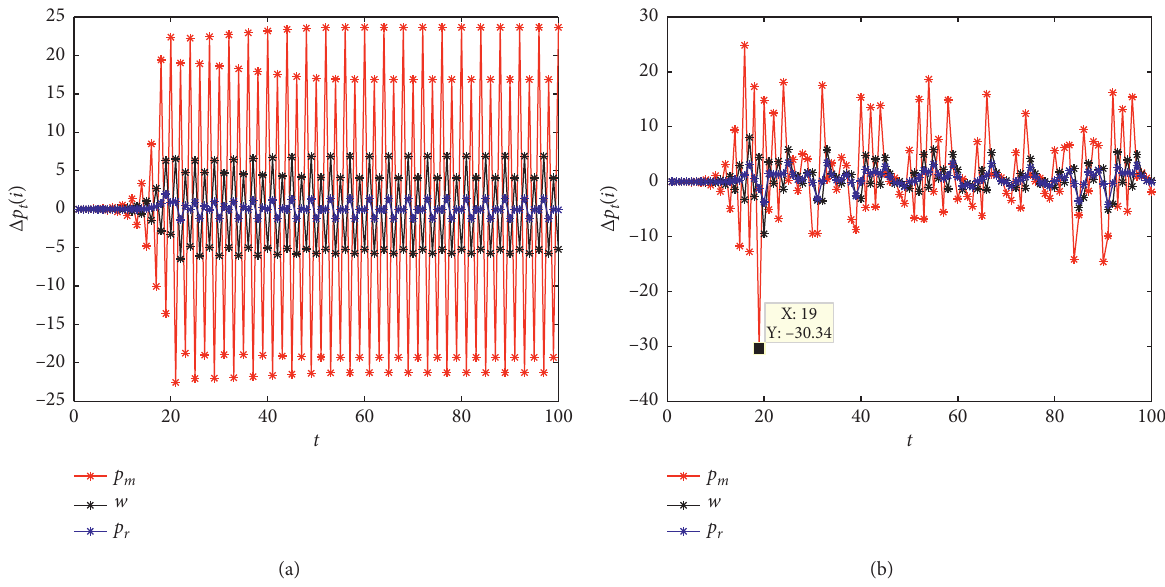
Figure 8: Sensitivity to initial values when w, p